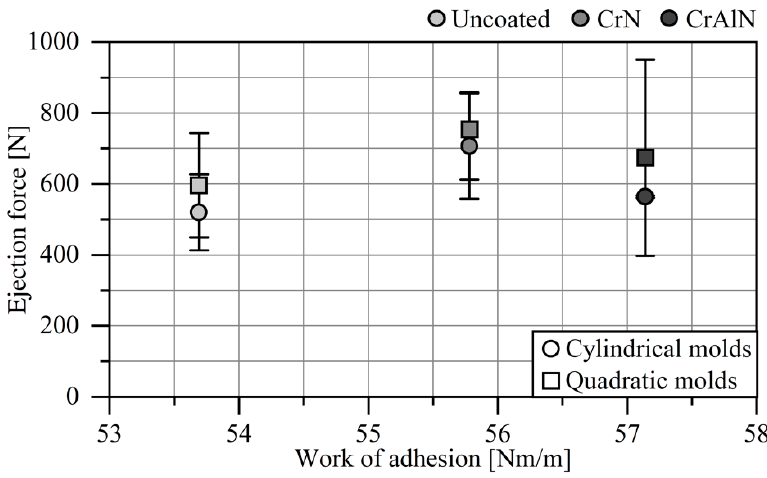
Figure 11. Ejection forces plotted against the work of adhesion with PP.